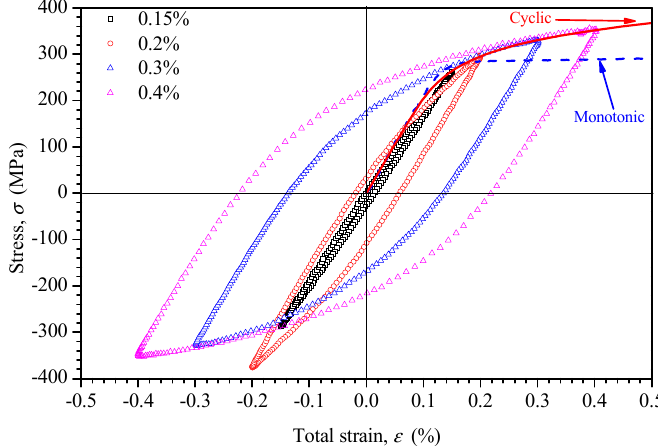
Figure 9. Stress–strain hysteresis loops and the fitted cyclic stress–strain curve by the test data.